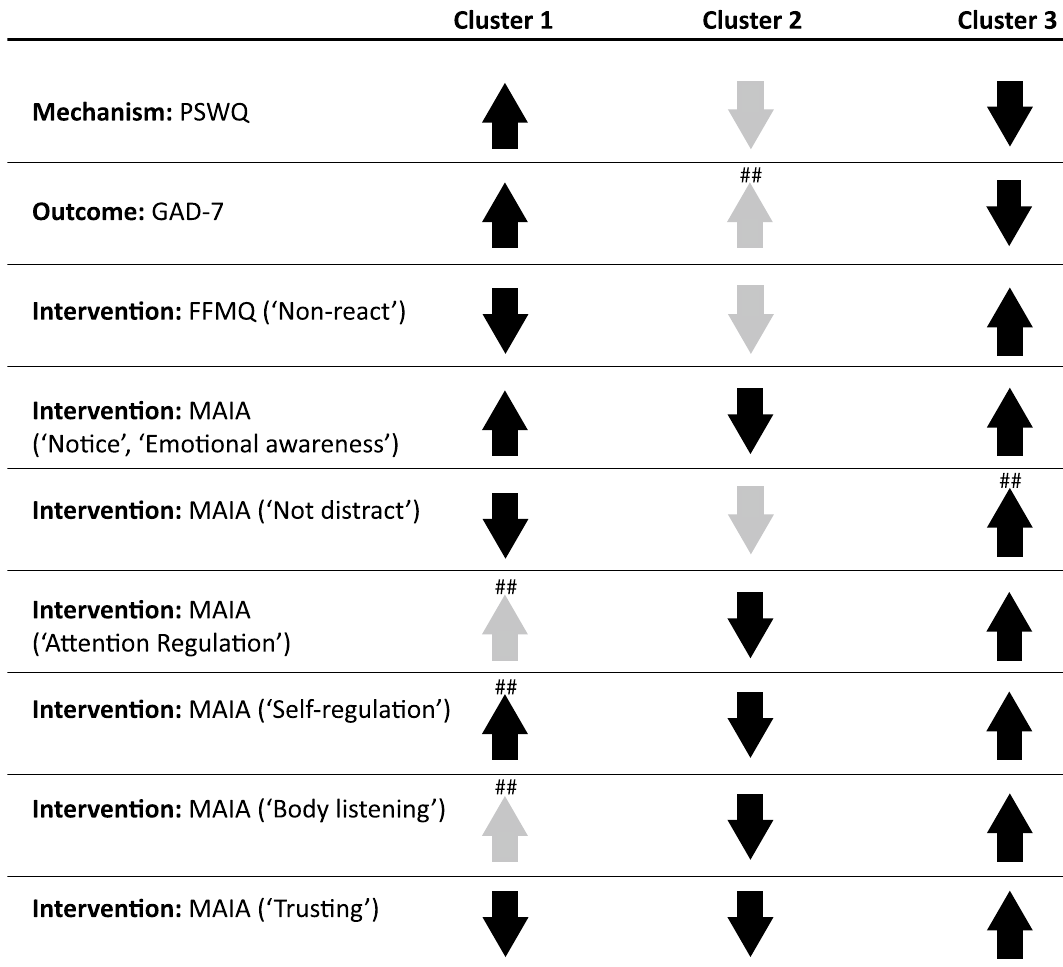
Table 1. Study 1 cluster description of individual questionnaire items. Questionnaires’ subscales are listed in parentheses when applicable. Items significantly contributing to cluster formation are included (see results from one-way ANOVA on questionnaire item z-scores with Cluster as a between-group factor, Table S2). 95% confidence intervals for each item’s within-cluster average were computed: Upward arrows indicate that the within-cluster z-score average for the scale/subscale’s items was positive and that > 50% of items had confidence intervals that exceeded the group mean (full upward arrows) or did not exceed the group mean (light upward arrows). Downward arrows indicate that the within-cluster z-score average for the scale/subscale’s items was negative and that > 50% of items had confidence intervals that preceded the group mean (full downward arrows) or did not precede the group mean (light downward arrows). PSWQ: Penn State Worry Questionnaire; GAD-7: Generalized Anxiety Disorder 7-item Scale; FFMQ: Non-Reactivity Subscale of the Five Facet